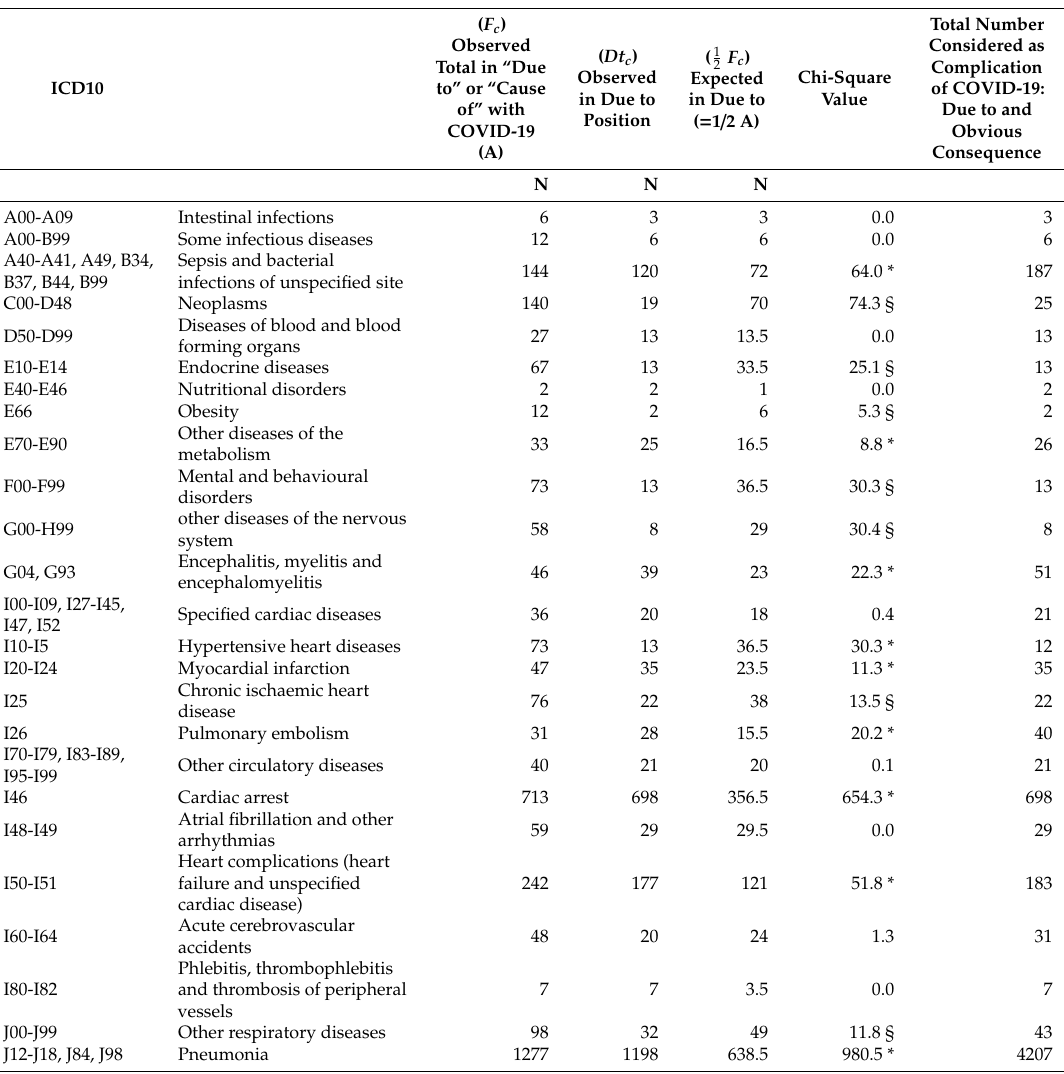
Table A2. Analysis performed for the inclusion of conditions as complication of COVID-19.